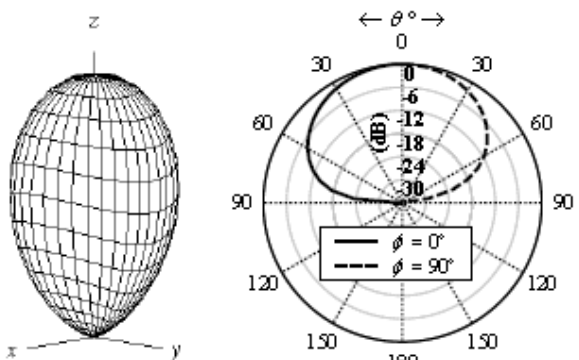
Figure 13: Radiation patterns for the 3-element CCLA backed with ground plane with β b Table 4: 3-Elements CCLAs backed with ground planes f o